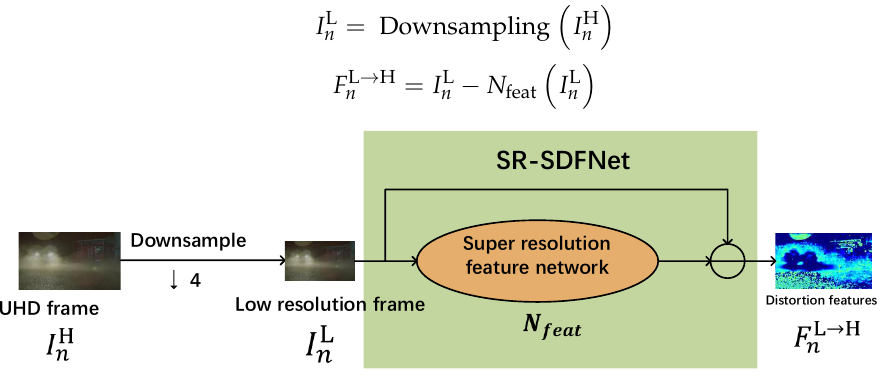
Figure 5. The network structure of the spatial distortion feature network